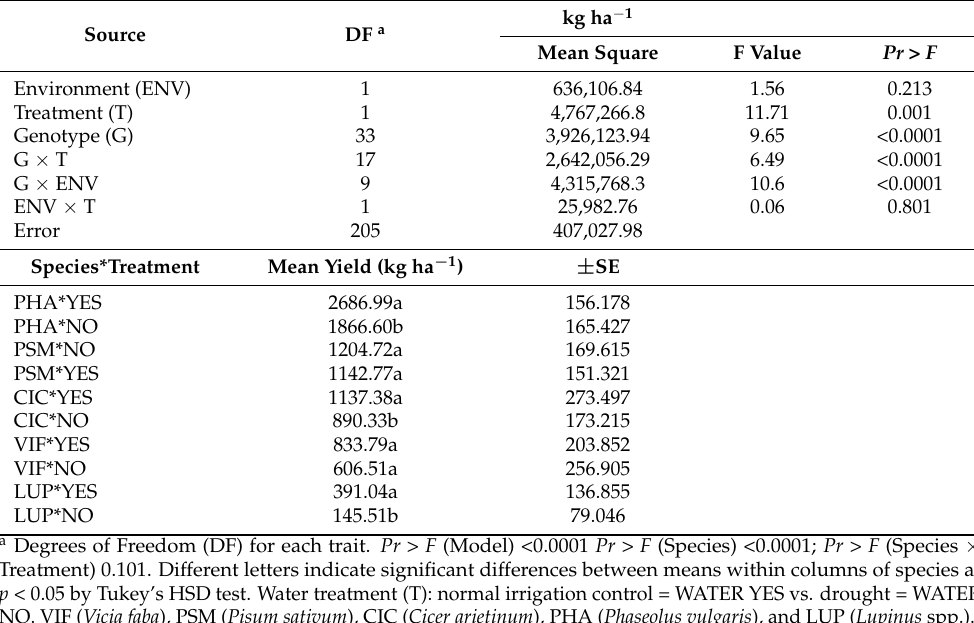
Table 4. Analysis of variance and Tukey’s HSD test among genotype varieties of the five grain legume